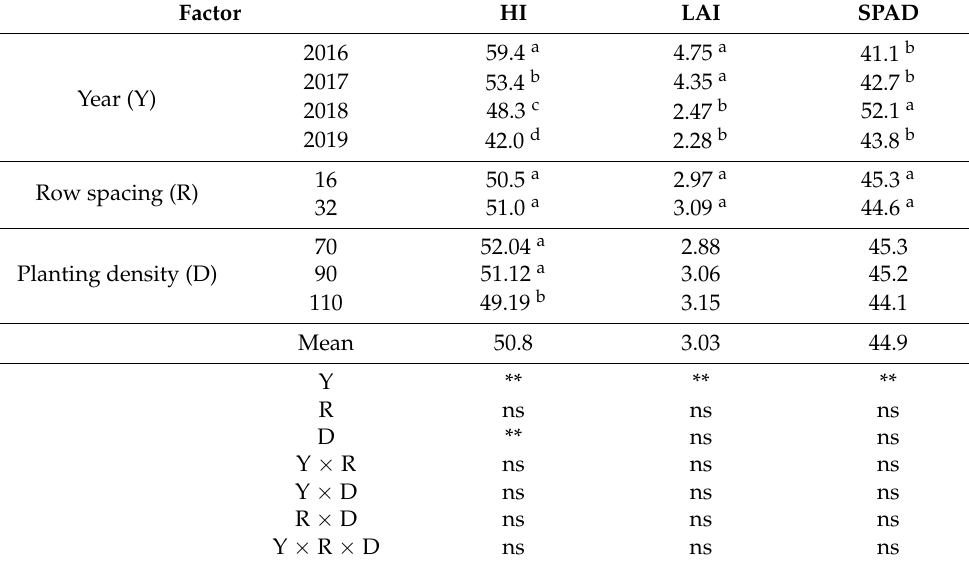
Table 7. Harvest Index (HI), Leaf Area Index (LAI), and Soil Plant Analysis System (SPAD) for pea depending on the year, row spacing, and plant density across the